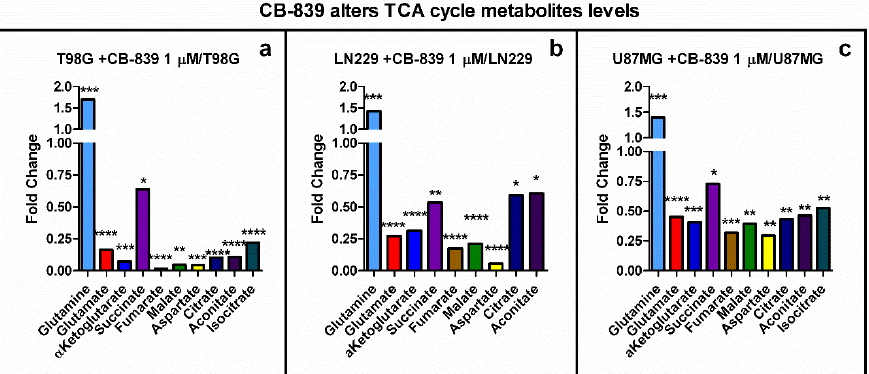
Figure 7. TCAC metabolites altered by specific GLS inhibitor CB-839. Results are depicted for T98G ( a ), LN229 ( b ), and U87MG ( c ). The samples were run in triplicate. For more details, see Section 2. * p < 0.05, ** p < 0.01, *** p < 0.001, **** p <